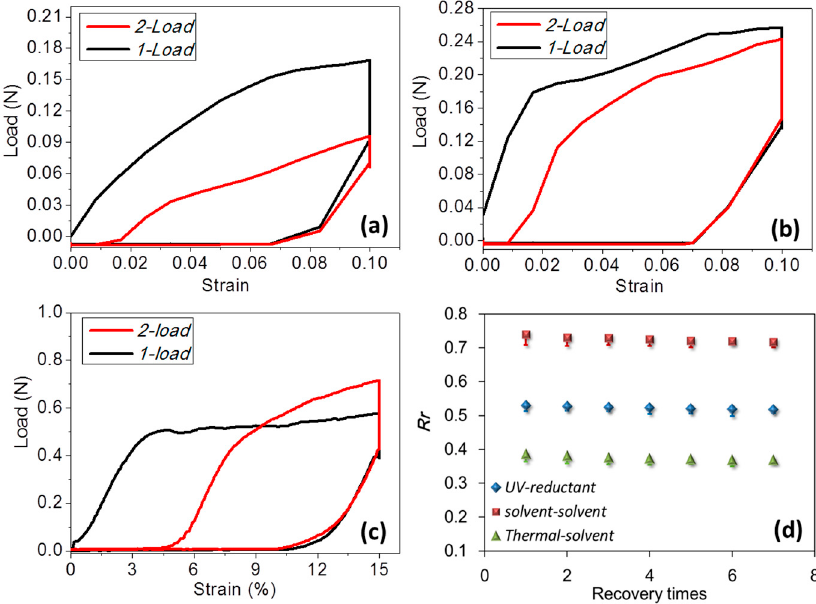
Figure 6. Experimental tests of the cyclic tensiles of goat hair fibers under the coupled stimuli of ( a ) UV (254 nm of light wave length)-reductant (NaHSO 3 1 M/L); ( b ) ethanol-water; ( c ) heat (85 ◦ C)-water; and ( d ) variation of R r values from the stretched shape to the innate shape with the repetition of the SM program.